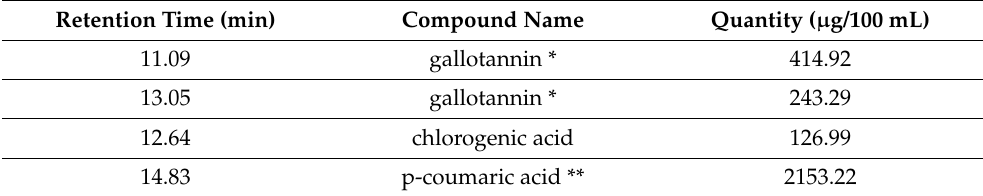
Table 1. Rosmarinus officinalis L. glycolic extract